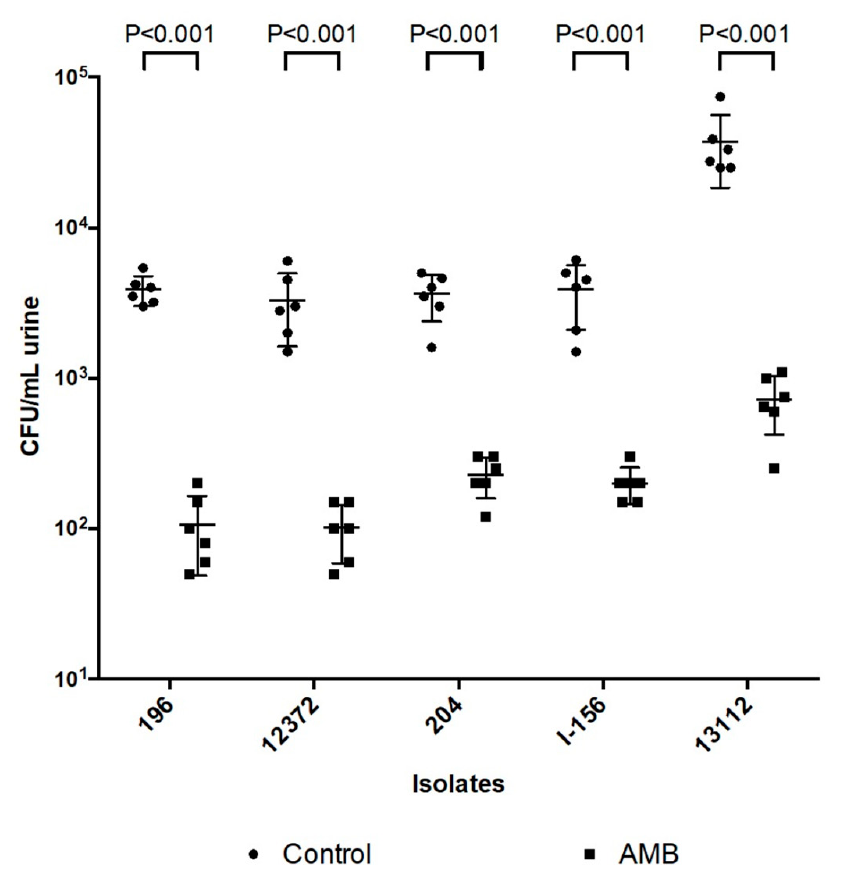
Figure 3. The effect of 2 days amphotericin B (AMB) treatment on the CFU in the urine in mice infected with isolates 196 (South Asian clade), 12,372 (East Asian clade), 204 (South African clade), I-156 (bloodstream isolate from the South American clade) and 13,112 (environmental isolate from the South American clade). Urine was collected on day 3. The bars represent the medians. Level of statistical significance is indicated at p < 0.001 (***).